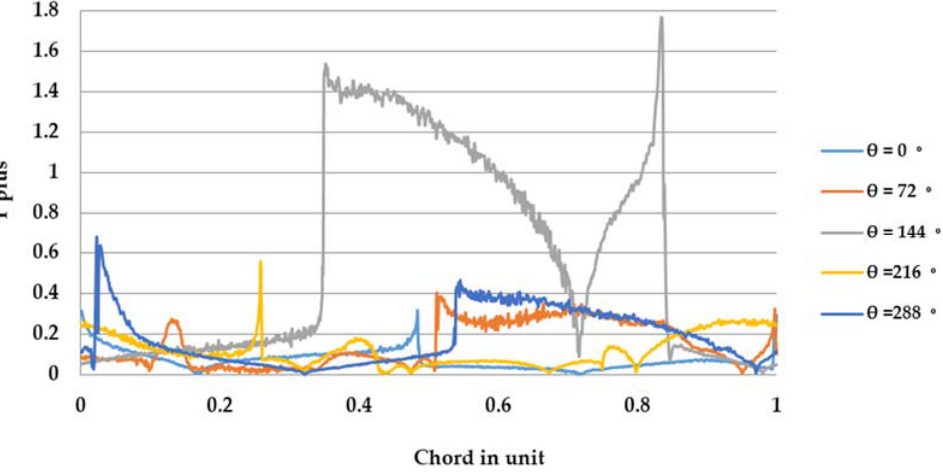
Figure 9. Results for Y plus values when the TSR = 3.